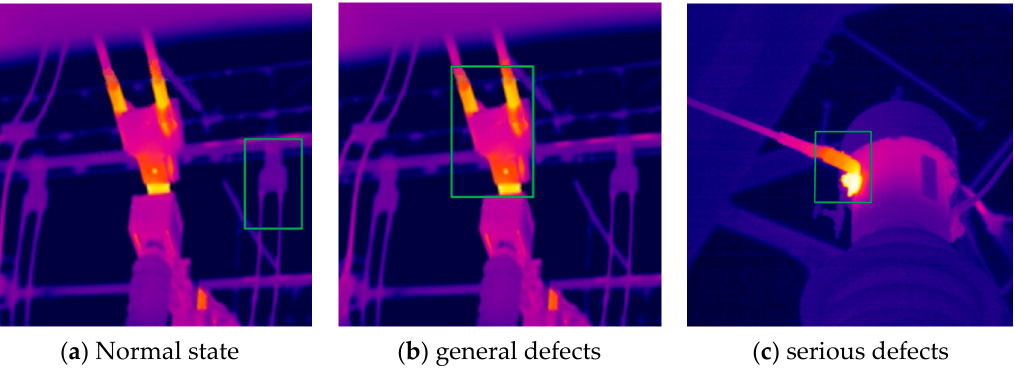
Figure 7. Example of high voltage lead connectors status.